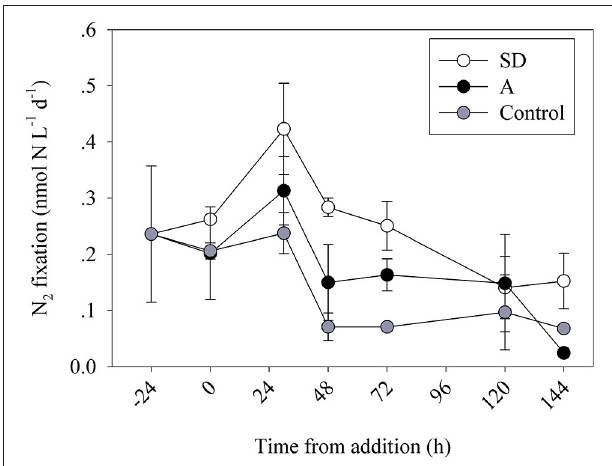
FIGURE 1 | Temporal changes in volumetric N 2 fixation rates during the mesocosm enrichment experiments. Data are averages of 3 replicate bottles per treatment of the control (gray), SD (white) and A (black) mesocosms during May 2012.